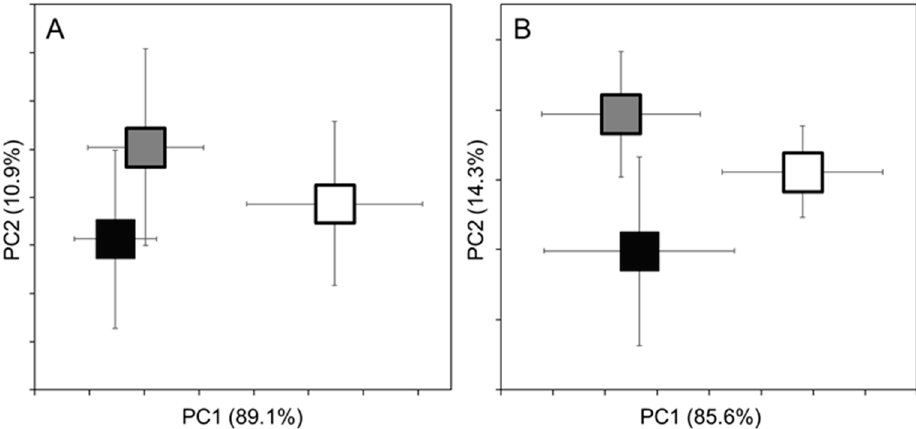
Figure 2. Principal Component Analysis plots of MALDI-TOF MS spectral datasets derived from gudgeon brain ( A ) and muscle ( B ) tissues. The groups were assigned based on the sample preparation type independently from the collection site and genetic features. Black square (Prep. Type 1): immediate field preparation; Grey square (Prep. Type 2): clove oil euthanization + immediate field preparation; White square (Prep. Type 3): the whole body was frozen and prepared in the lab after 30 days incubation on − 30 °C. For clarity, only the group centroids are shown, with vertical and horizontal error bars indicating the standard deviation of data. The explained variance in each axis is indicated in parenthesis. The original PCA showing all individuals data are available in the Supplementary Figure S1).